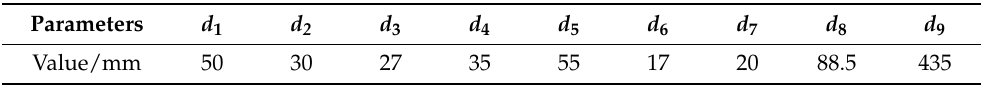
Table 2. Dimensions of bolt-sphere joints with